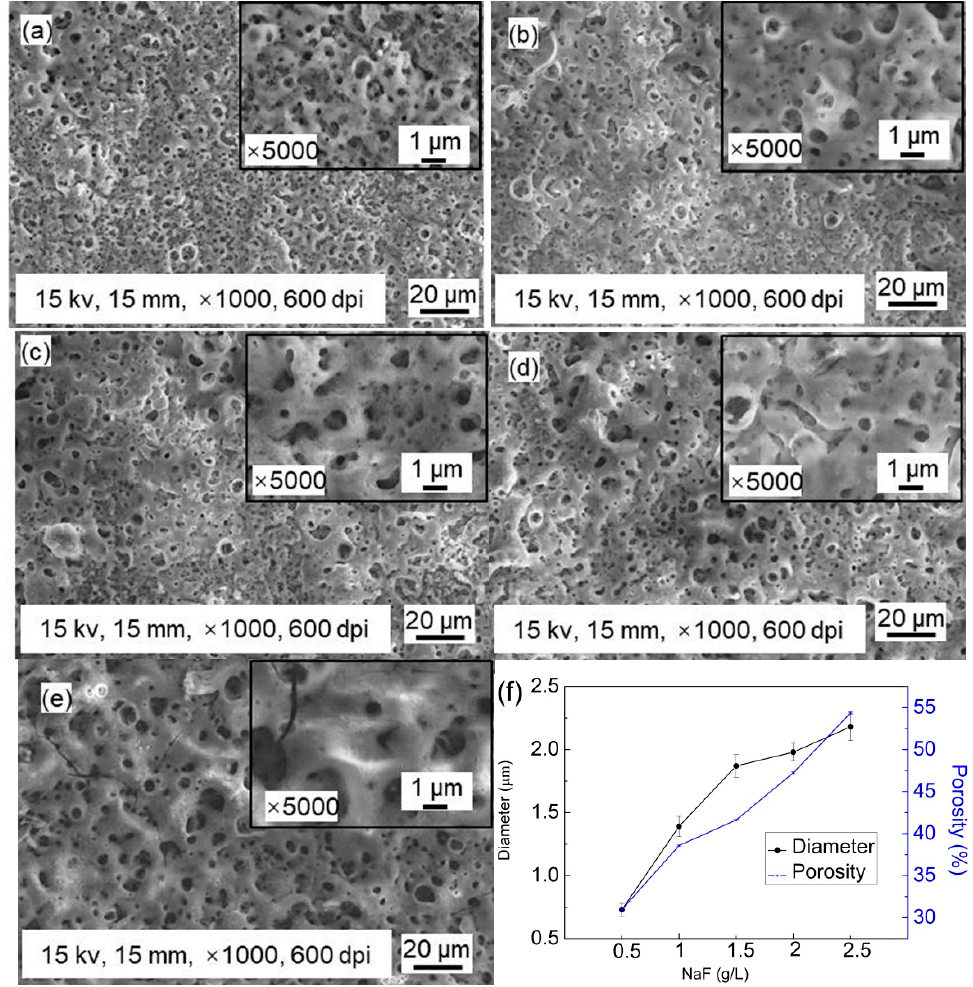
Figure 1. Surface morphologies of MAO coating with different NaF concentrations: ( a ) 0.5 g/L; ( b ) 1 g/L; ( c ) 1.5 g/L; ( d ) 2 g/L; ( e ) 2.5 g/L. ( f ) The curve of the diameter of pores and porosity vs. MAO coating with different NaF concentrations.